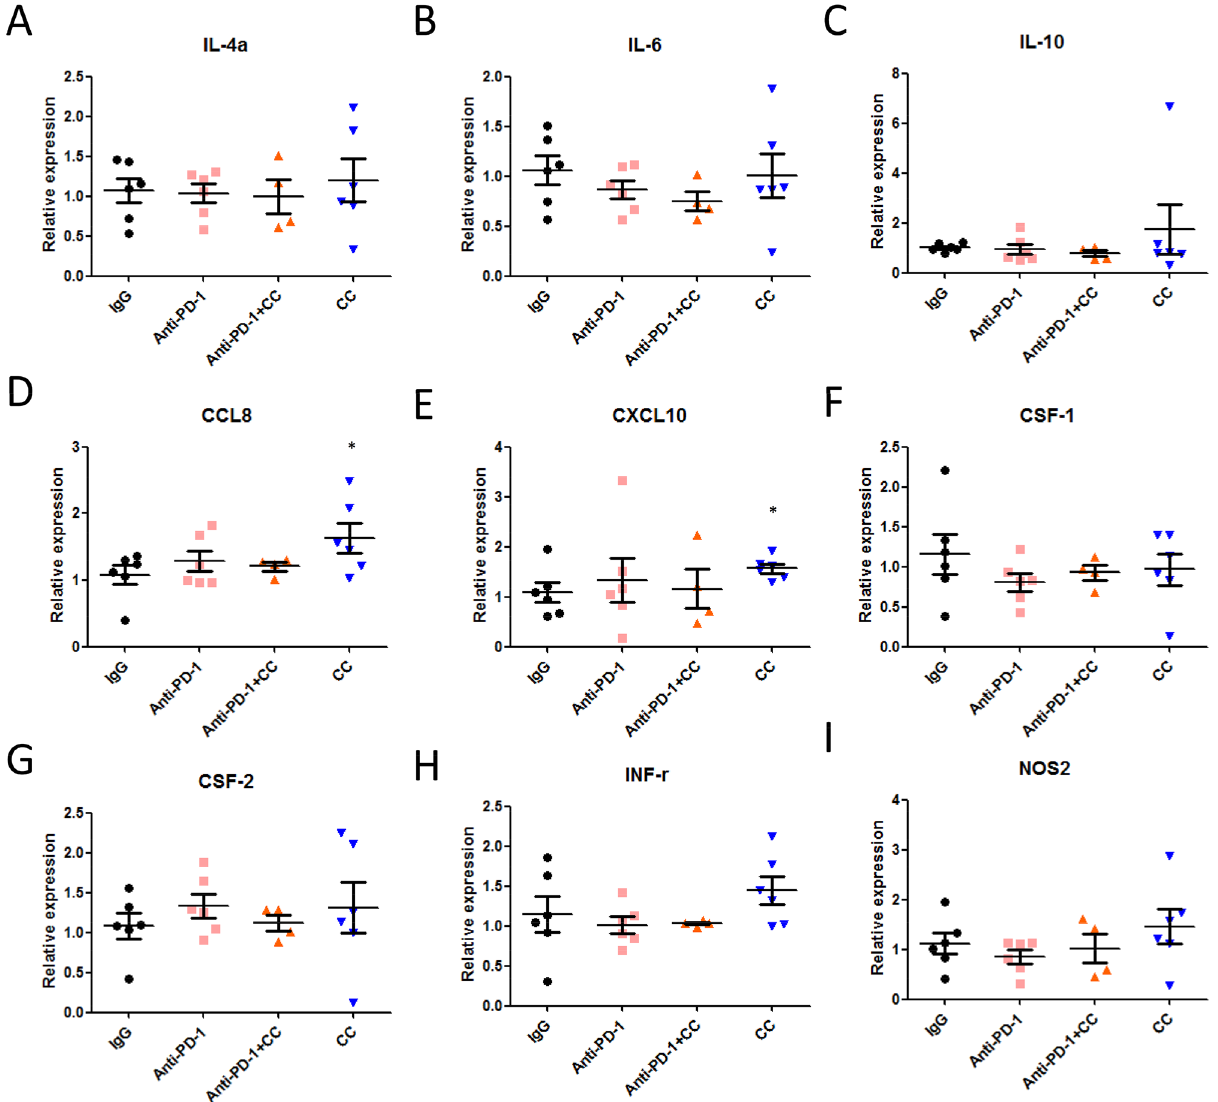
Figure 7. Determination of chemokines and NOS2 expression level in CT26 tumors. Total mRNA was extracted from anti-PD-1, anti-PD-1 + chidamide (CD) + celecoxib (C), CD + C, and IgG-treated tumors (n = 4–6 for each group). mRNA levels of genes were determined by qPCR. Data are presented as mean ± standard deviation (SD). *p < 0.05 by unpaired Student’s t-test. ( A ) IL-4a; ( B ) IL-6; ( C ) IL-10; ( D ) CCL8; ( E ) CXCL10; ( F ) CSF-1; ( G ) CSF-2; ( H ) INF-γ; ( I )